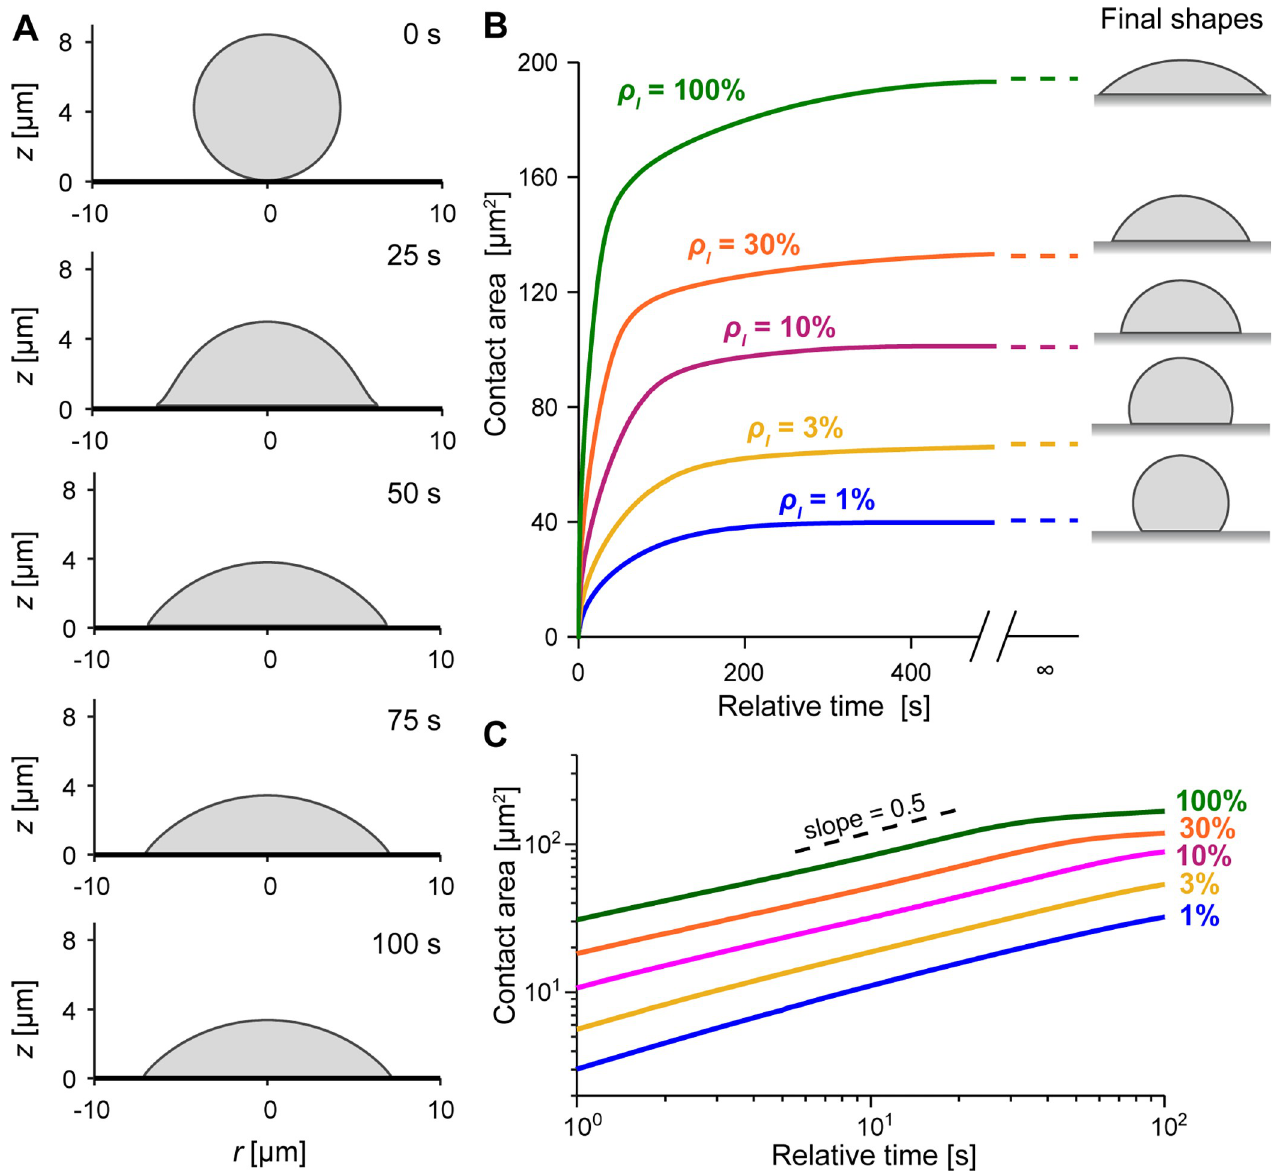
Fig 3. Predictions of the Brownian zipper model. (A) A model cell spreading on the highest tested ligand density (100%) quickly approaches a spherical cap morphology. Time stamps are included for each snapshot. (B) Curves of contact area vs. time show that the spreading rate decreases monotonically. The contact area ultimately approaches steady-state values predicted by the Young-Dupre equation (dashed lines). Predicted equilibrium shapes are included on the right. (C) Log-log plot of contact area vs. time is nearly linear over the initial spreading phase. The slope of this line corresponds to the exponent of a power law describing contact area growth as a function of time. The dashed line shows a slope of 0.5 for